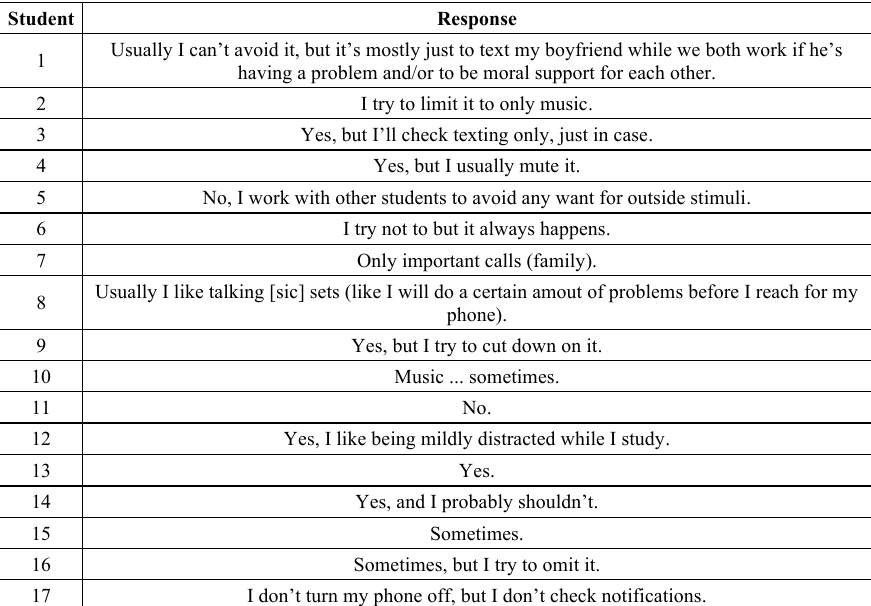
Table 4. Question 4: Do you allow for outside stimuli from your phone